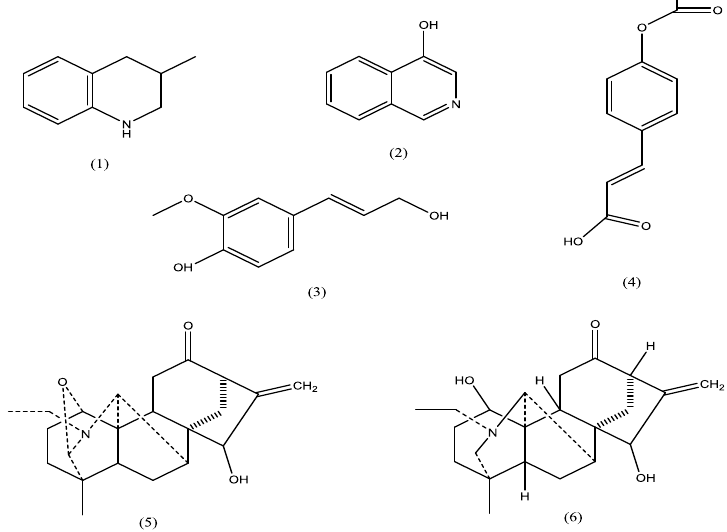
.Fig. 1. Structures of the compounds (1-6) determined from L.ilicifolius Table 2. Evaluation of antibacterial activity of the different samples from L.ilicifolius